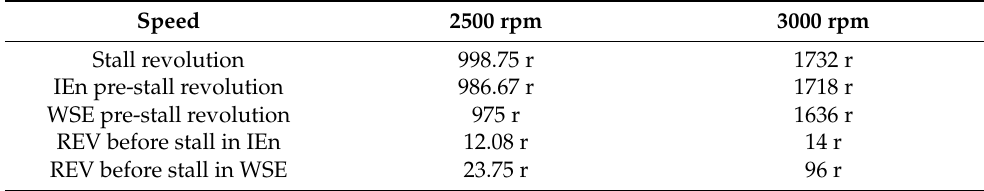
Table 2. The pre-stall time of IEn and WSE.